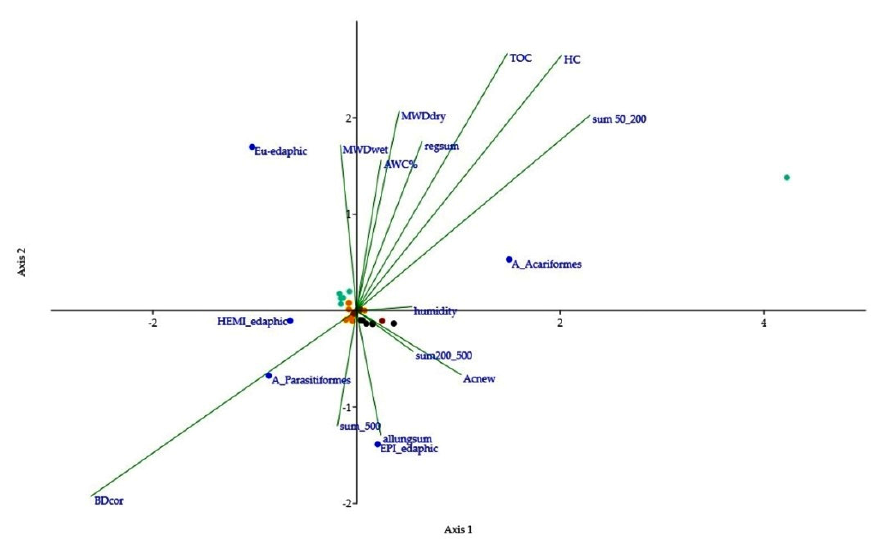
Figure 8. Canonical Correspondence Analysis (CCA) ordination biplot of the total dataset showing the environmental factors (arrows) and microarthropod group distributions (dots). Positioning of the microarthropod group along each arrow indicates the approximate ranking of the weighted av- erage of the group with respect to that factor.